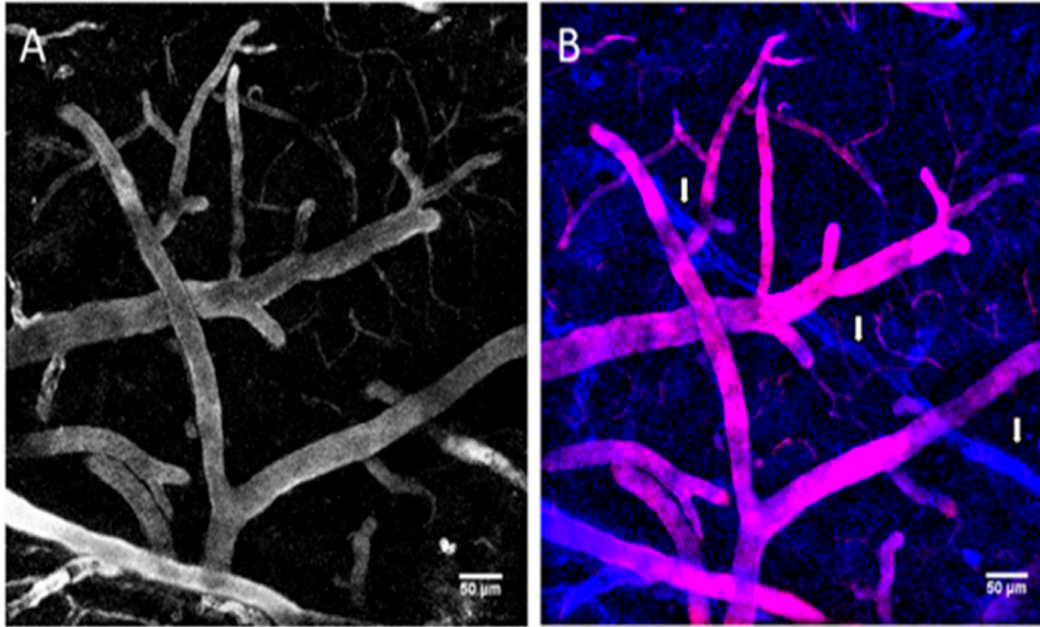
Figure 8. Intravital imaging of the mouse brain vasculature with Tobacco mosaic virus (TMV)-BF3 particles. ( A ) Mouse brain vessels labeled with TMV-BF3 at 1 h after intravenous injection into the tail vein. ( B ) Same observation window as shown in (A) but after a second injection, this time with sulforhodamine B; blue, fluorescence emitted from TMV-BF3; red, fluorescence emitted from sulforhodamine B. The 3D projections were performed with Fiji software using the standard deviation projection method. Reproduced with permission from [140]. Copyright, 2016,